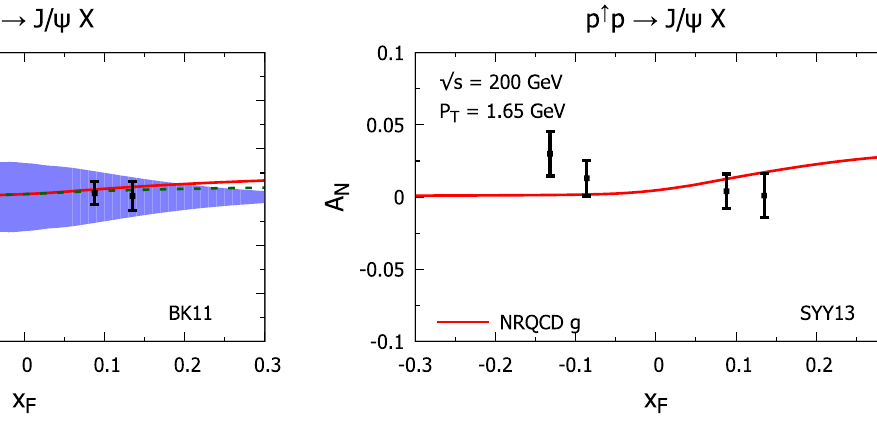
pared against PHENIX data [8]. The curves are calculated adopting the parameters in Eq. (21) for the GSF. The blue band is obtained by using this set of data to constrain the GSF (see